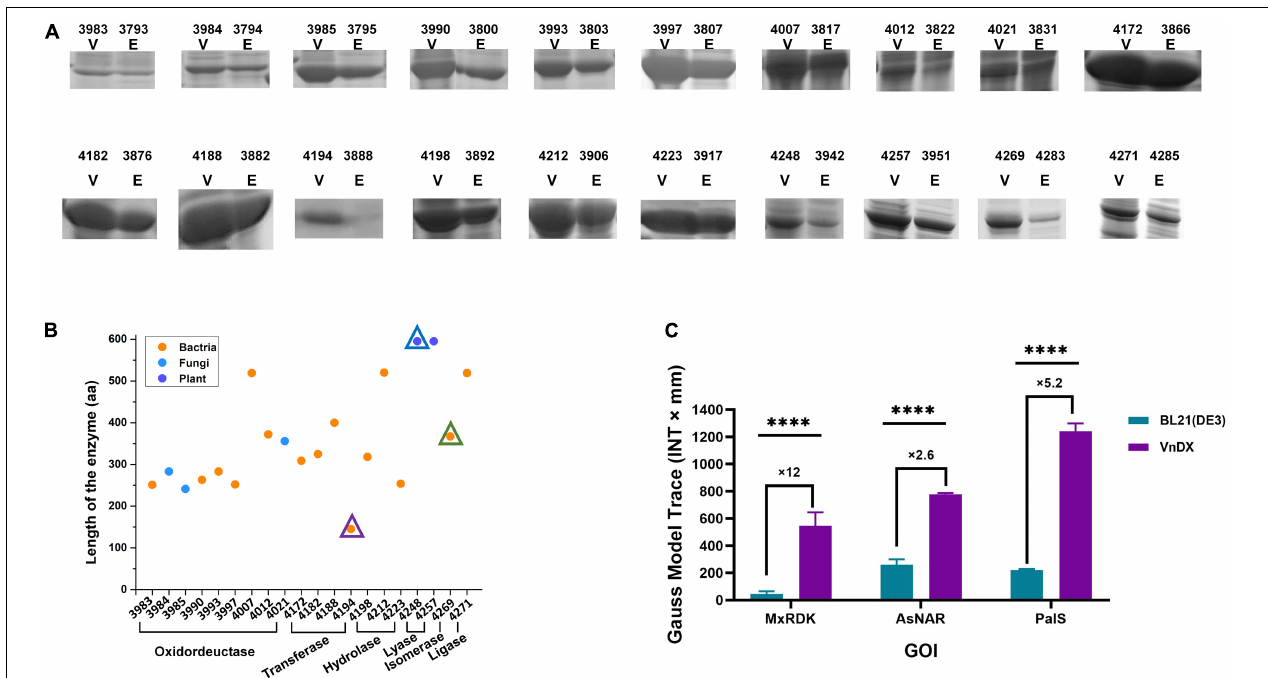
FIGURE 2 | Analysis of the spectrum of highly expressed genes of interest (GOIs) in V. natriegens VnDX. (A) Sodium dodecyl sulfate polyacrylamide gel electrophoresis (SDS-PAGE) comparison of 20 highly expressed GOIs. Here, 0.15 OD 600 (10-well gel) or 0.075 OD 600 (15-well gel) prepared crude protein samples were loaded to the corresponding protein gel wells. V, V. natriegens VnDX; E, E. coli BL21(DE3). Numbers above the SDS-PAGE lanes represent strain numbers of 20 highly expressed GOIs in both hosts. The detailed information of these GOIs was marked with blue asterisk in Supplementary Table 3 . (B) Classification, sources, and protein length analysis of 20 GOIs with high expression in V. natriegens . Numbers of horizontal axis represents V. natriegens strain numbers of 20 highly expressed GOIs. The GOI indicated by the three triangles corresponds to three enzymes in (C) . (C) Quantity comparison of three highly expressed GOIs with poor expression in E. coli . MxRDK: Ribonucleoside diphosphate kinase from M. xanthus , CIBT3888 and CIBT4194; AsNAR: N-acetyl amino acid racemase from Alcaligenes sp. CIBT3942 and CIBT4248; PaIS: Isoprene synthase (K308R, C533W) from Populus alba (codon Optimized for E. coli ) CIBT4283 and CIBT4269. Error bars represent the SD of n = 3 technical replicates. Quantitative analysis was calculated by software Quantity One 1-D; GraphPad Prism software was used to analyze the significance by t- test, **** P <